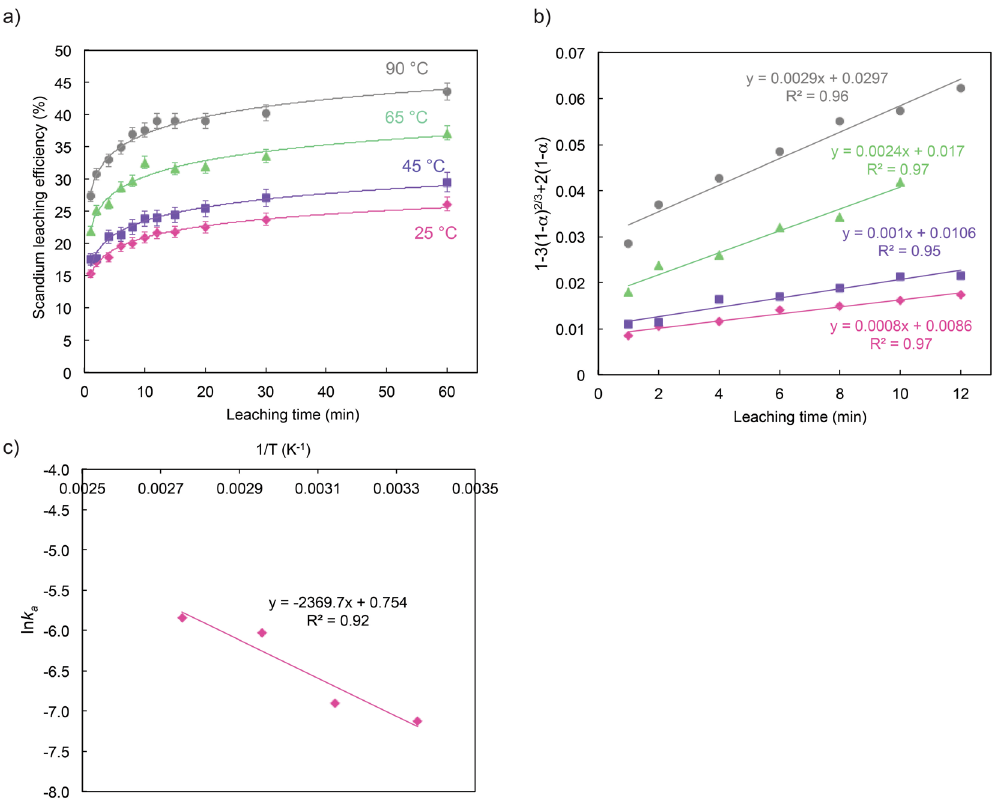
Figure 6. ( a ) Leaching efficiency of scandium (Sc) as a function of time at various temperatures using 1.5 M H 2 SO 4 as the leaching agent. ( b ) Plots of versus time at various leaching temperatures. ( c ) Arrhenius equation plot to determine the apparent activation energy ( E a ) of the leaching reaction. Error bars represent the standard error of the mean for four